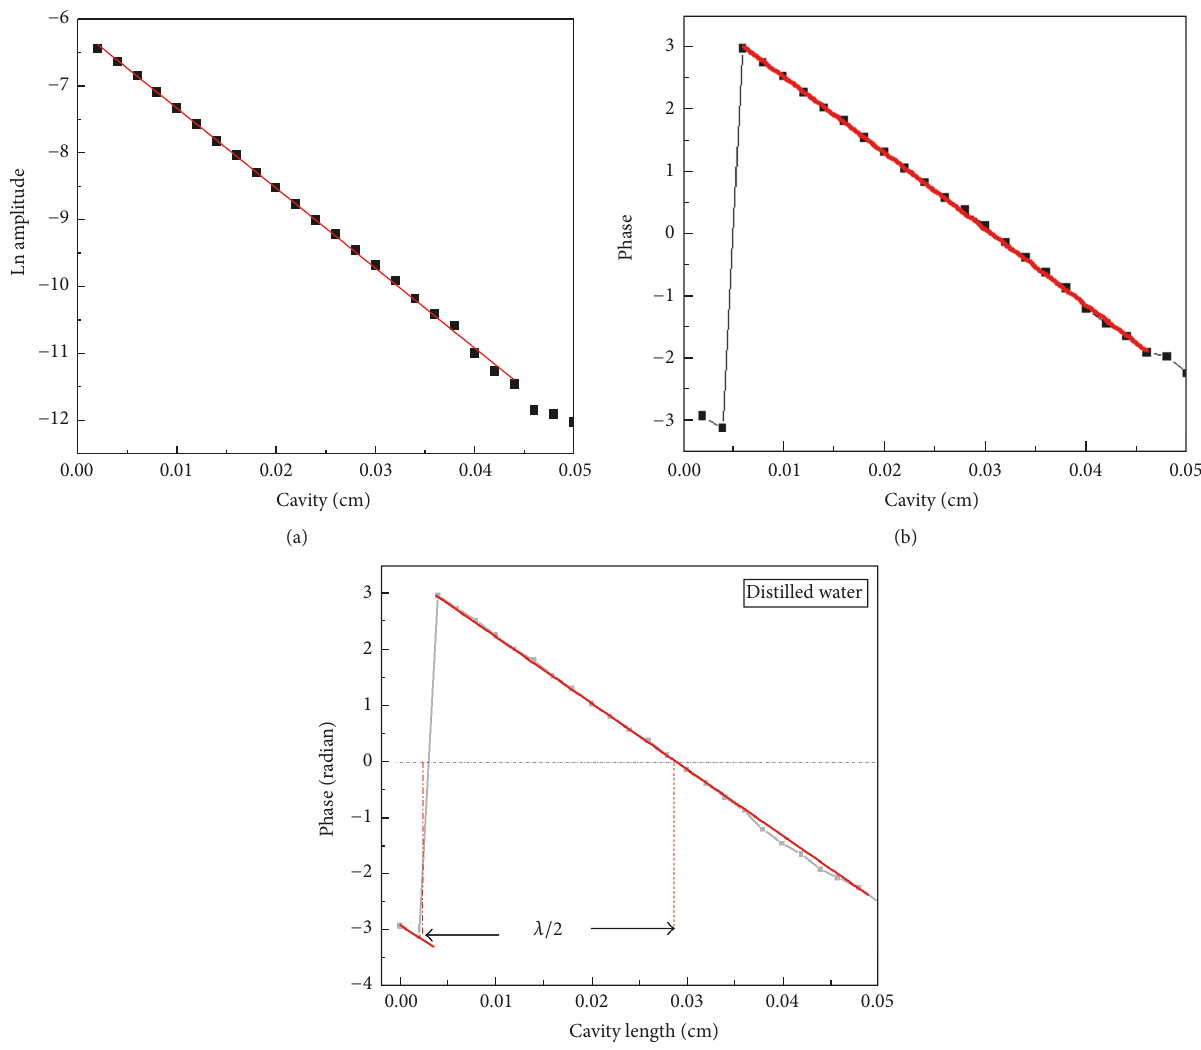
Figure 5: The typical behavior of the Ln amplitude and the phase as a function of the cavity length for the distilled water, at 6.73 Hz, (a) the plots of logarithmic amplitude and (b) the phase versus the cavity length, and (c) the plot of phase versus the cavity length; the half thermal wavelength was directly calculated by obtaining the cavity length between two experimental data sets; the phase equals ( −𝜋 ) and the phase equals